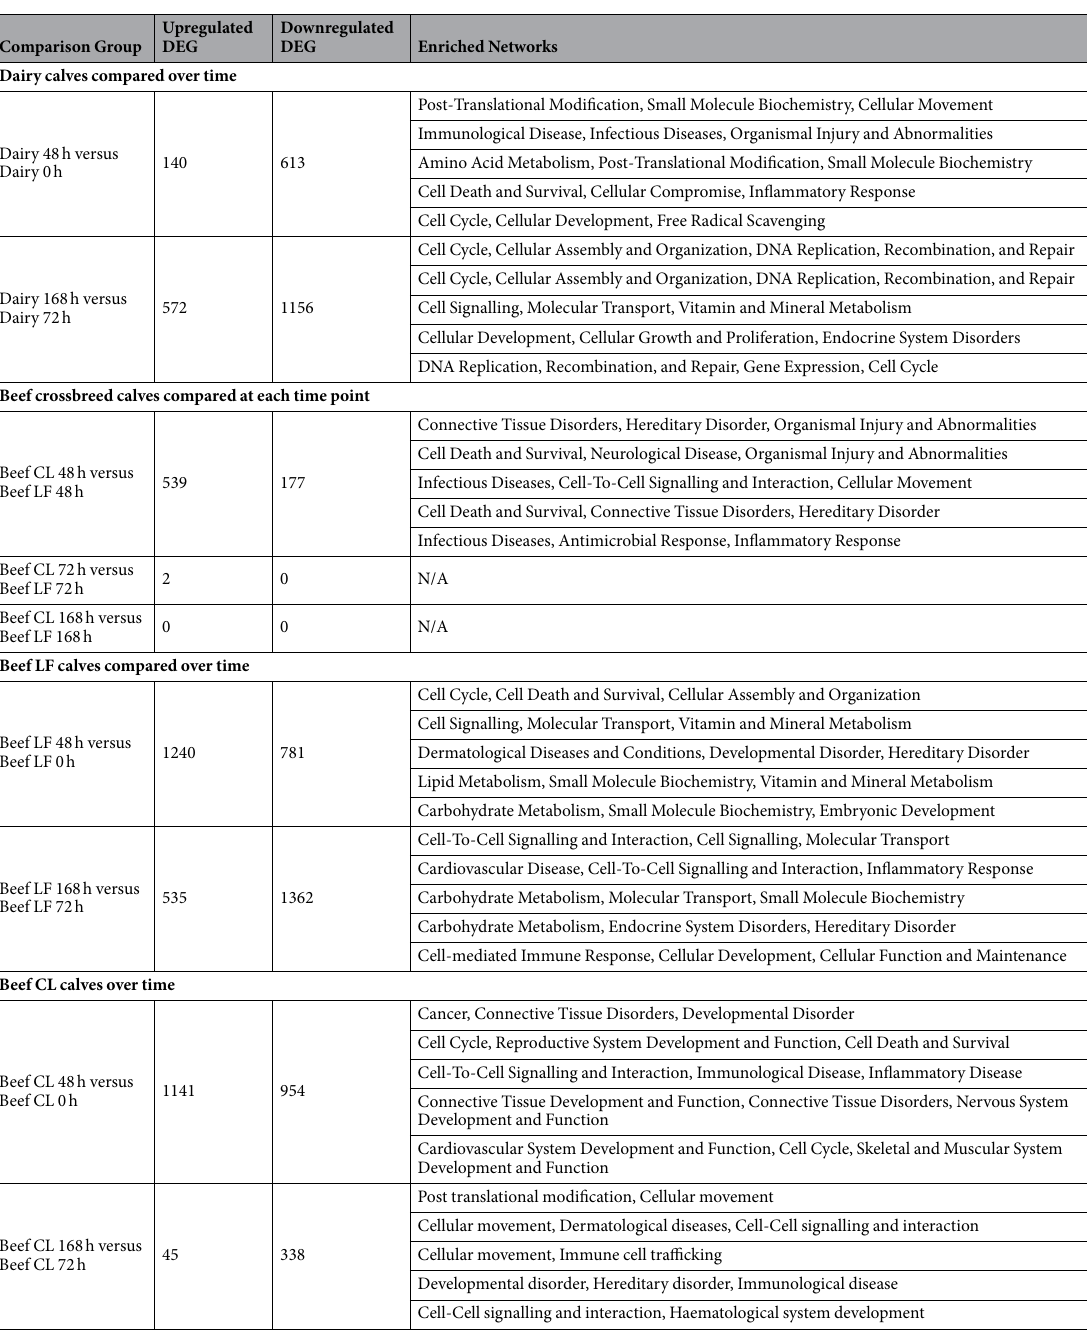
Table 2. Levels of upregulated and downregulated DEG across all comparisons and over-represented networks across comparisons with sufficient levels of